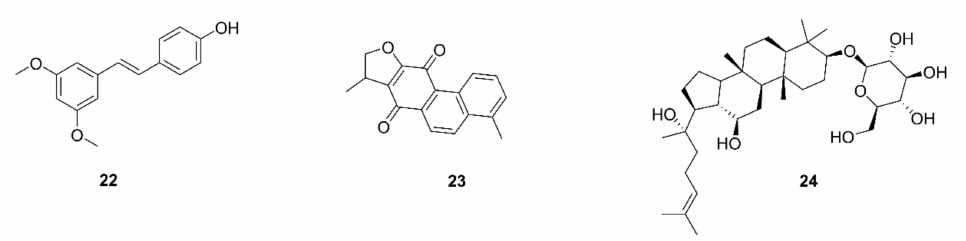
Figure 5. Chemical structures of natural compounds targeting TAMs ( 22 – 24